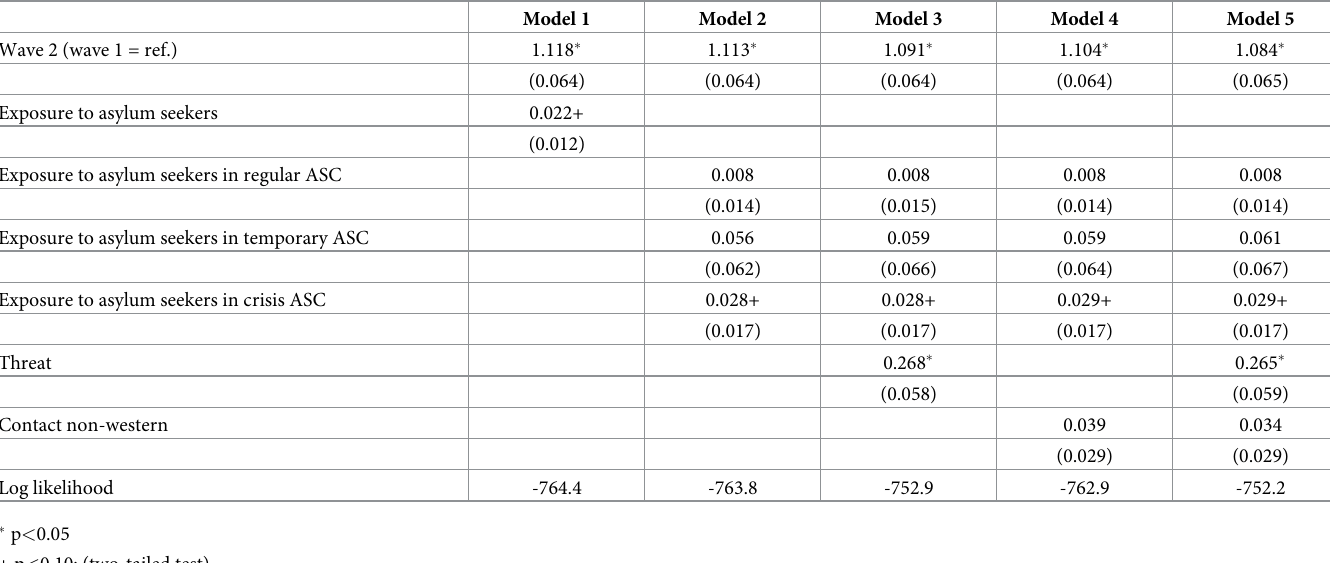
Table 2. Fixed effects models predicting voting intention for the PVV (standard errors in parentheses; N i = 1,389; N nb =